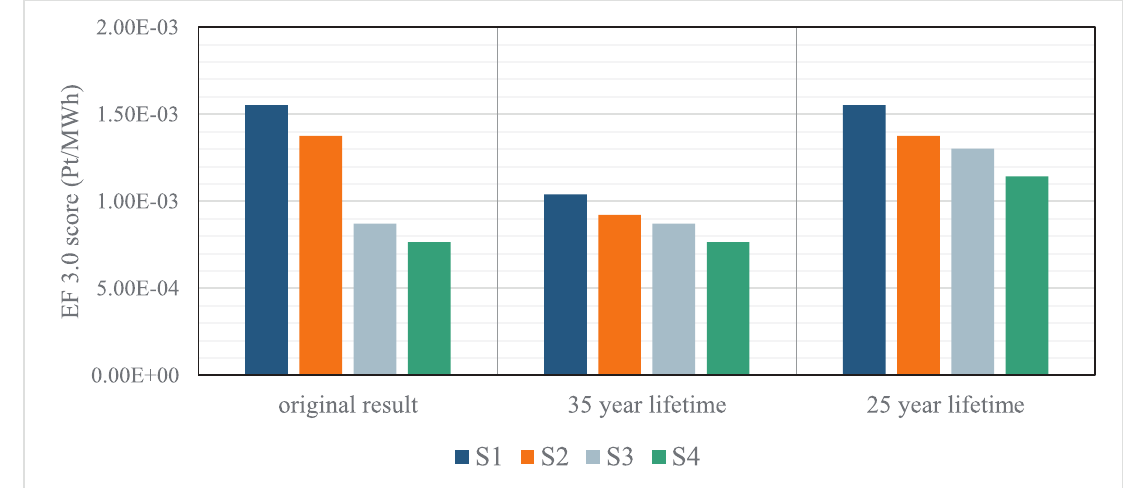
Fig. 6. Lifetime effect to normalized and weighted EF3.0 single score LCA results (for silicon within the PV module